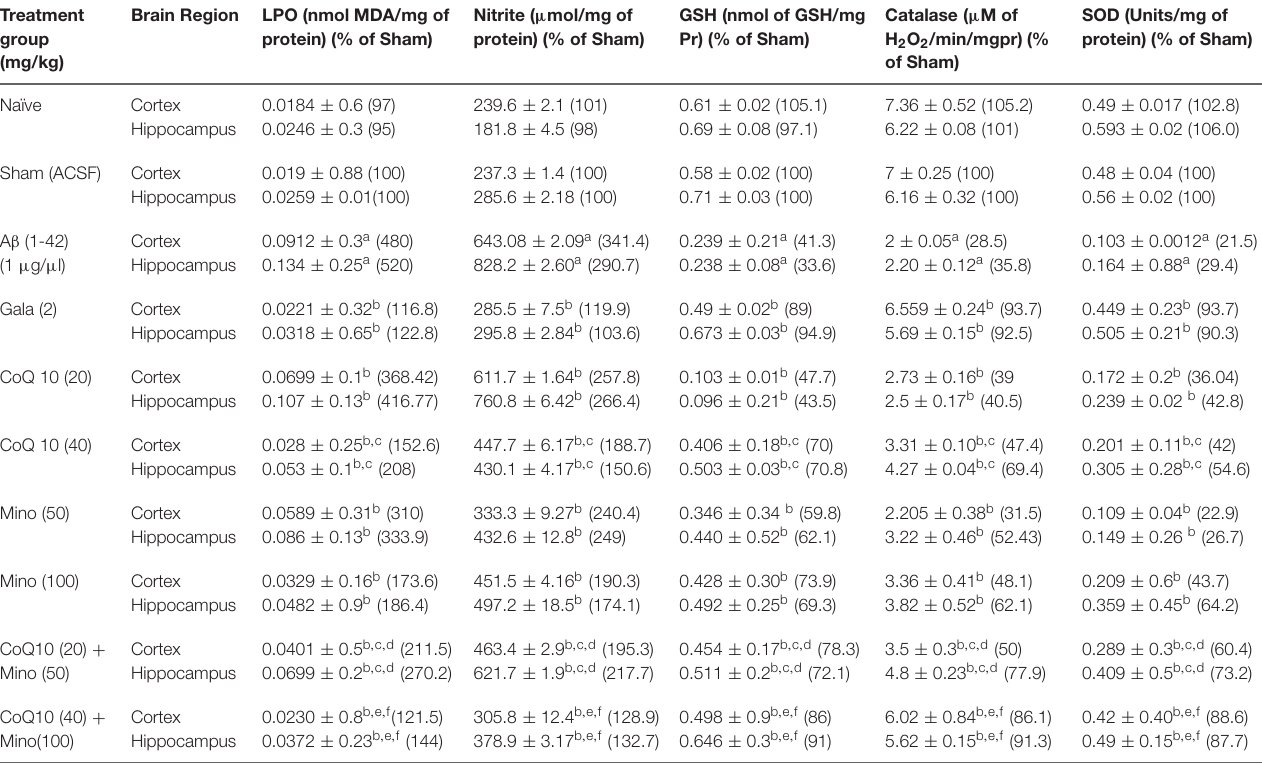
TABLE 2 | Effect of CoQ10 and minocycline on oxidative stress parameters in A β (1-42) treated animals. Treatment